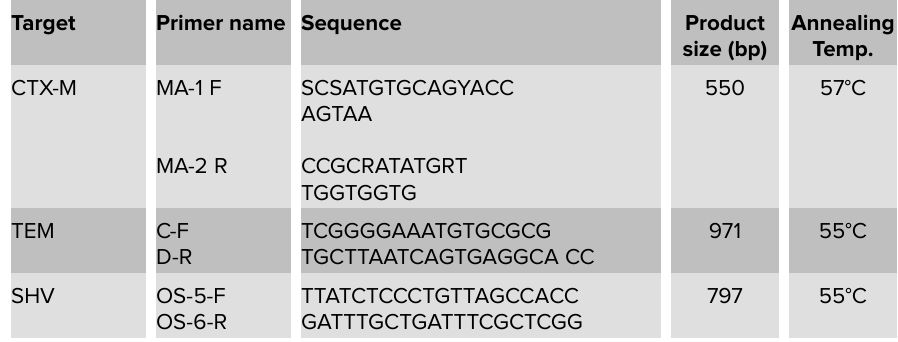
TABLE 1: Primer sequences used in the detection of genes.